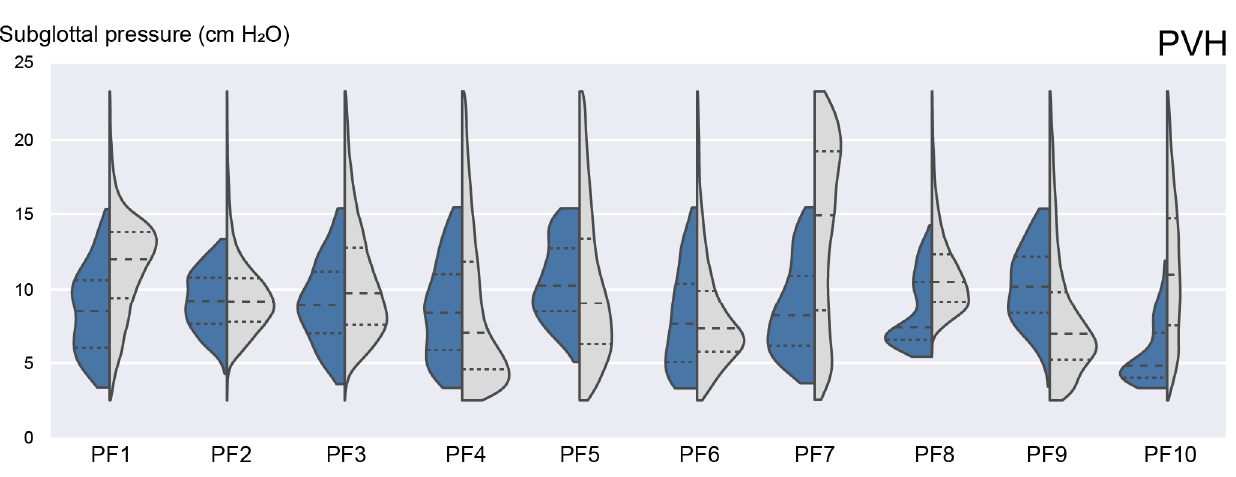
Figure A1. Split-violin plots comparing laboratory (left distribution) and ambulatory (right distri- bution) estimates of Ps for each patient.